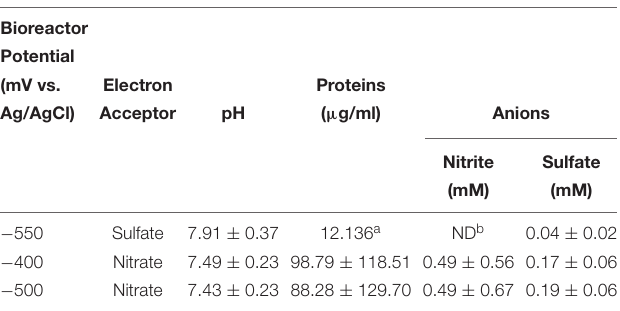
TABLE 2 | Average pH, planktonic biomass proteins, nitrite and sulfate concentrations in media from electrochemical bioreactor media exchanges after 30 days of electrochemical